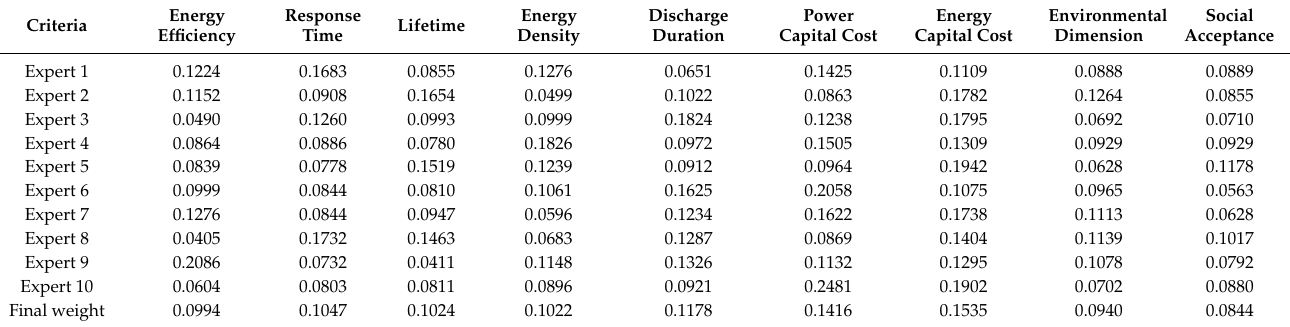
Table 7. Weights of the evaluation